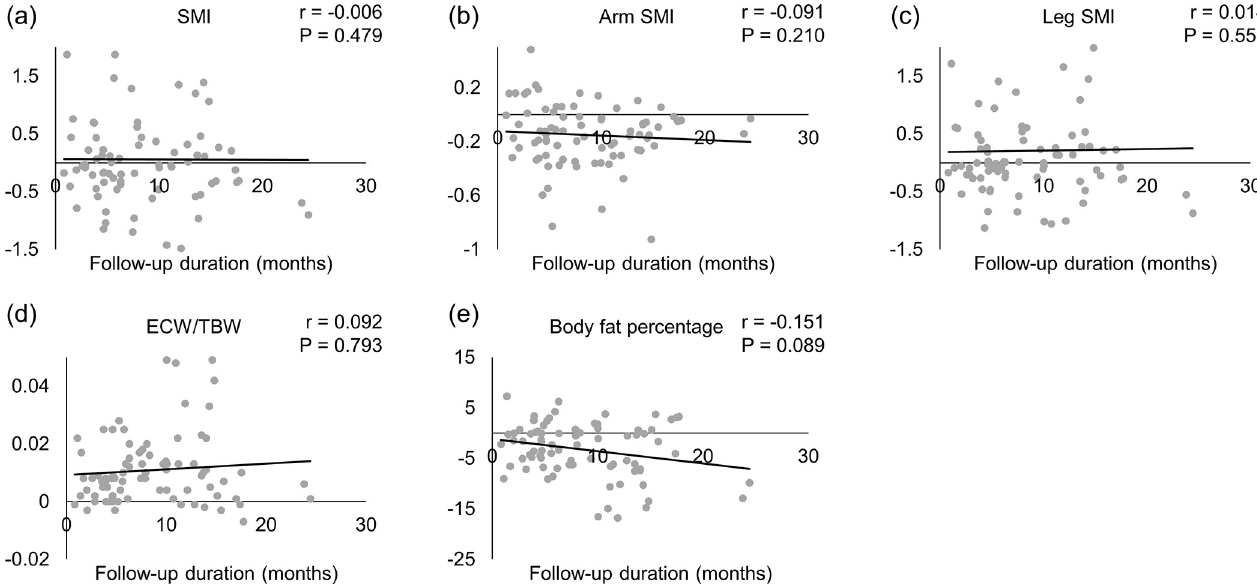
Fig 4. Scatter plots and approximate lines of changes in body composition and duration. (a) Total skeletal muscle mass index (SMI), (b) arm SMI, (c) leg SMI, (d) extracellular water to total body water ratio (ECW/TBW), and (e) body fat percentage. There was no correlation between the follow-up duration and the amount of change in body composition. The horizontal axis shows the time from the start of lenvatinib treatment to the day of the second body composition measurement, and the dots show the percentage change in body composition. (b) The arm SMI decreased in many cases and (d) the ECW/TBW increased in many cases.